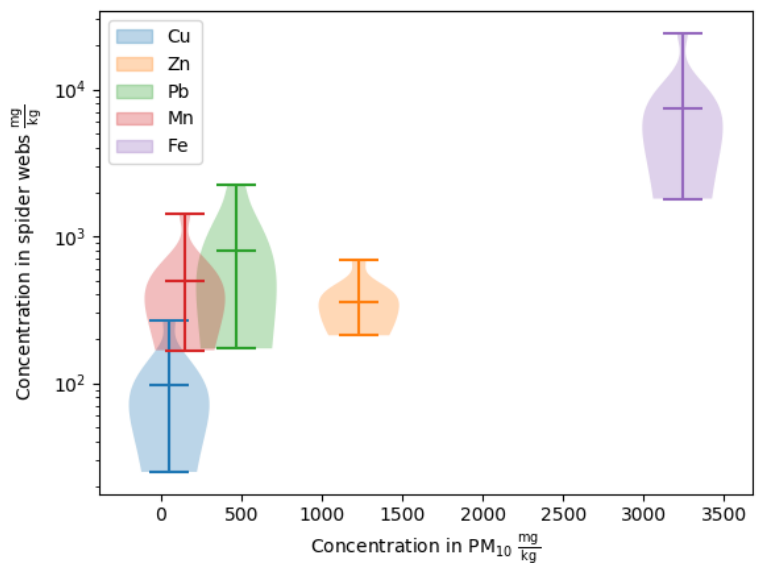
Figure 3. Concentrations in spider webs with relation to the concentration measured by Horiba PX-375. The horizontal position of the violin is the total concentration of PM 10 while in the vertical direction the violin represents the distribution of concentration .